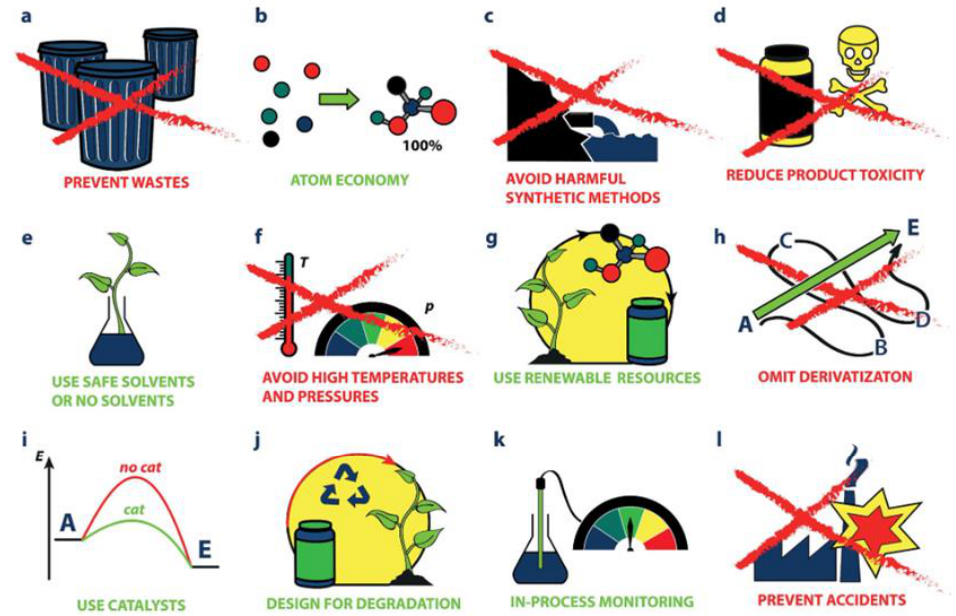
Figure 1. The twelve principles of green chemistry. (Reprinted with permission from Ref [4]. Copyright 2016 John Wiley and Sons.)